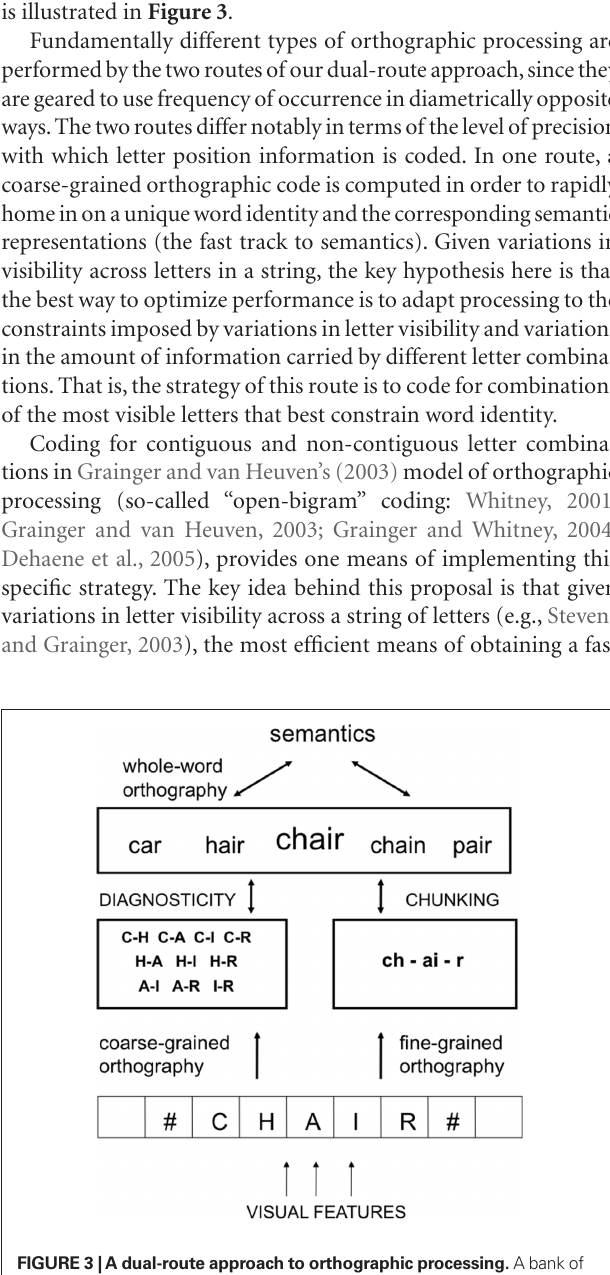
Figure 3 | A dual-route approach to orthographic processing. A bank of location-specific letter detectors send activation forward to two types of sublexical location-invariant orthographic representations: (1) coarse-grained representations that code for the presence of informative letter combinations in the absence of precise positional information, and (2) fine-grained representations that code for the presence of frequently co-occurring letter combinations (multi-letter graphemes, affixes). The coarse-grained code optimizes the mapping of orthography to semantics by selecting letter combinations that are the most informative with respect to word identity ( diagnosticity ), irrespective of letter contiguity. The fine-grained code optimizes processing via the chunking of frequently co-occurring contiguous letter